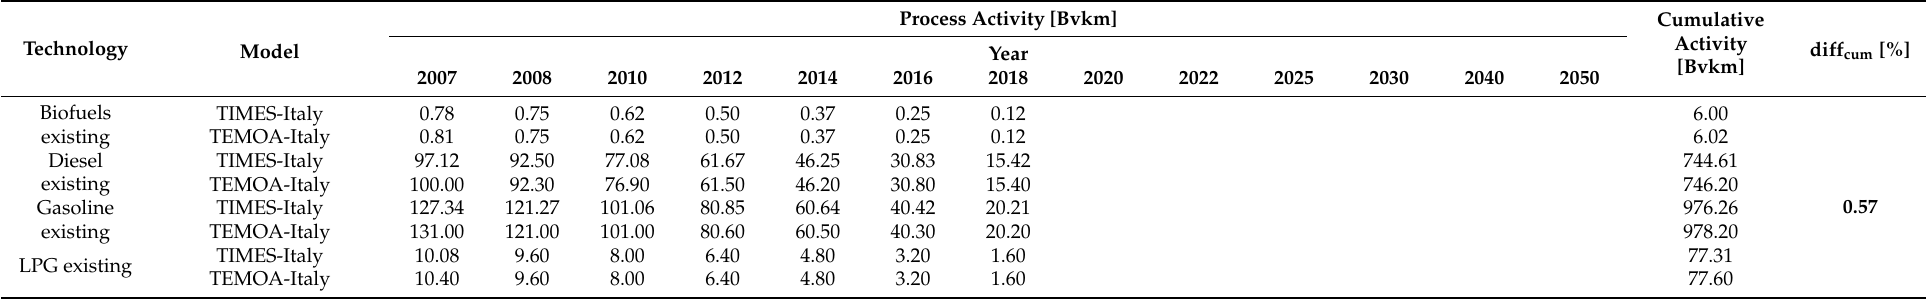
Table A6. Activity of transport road cars and cumulative activity along the entire time horizon, compared for TIMES-Italy and TEMOA-Italy results. Evaluated average relative difference on cumulative